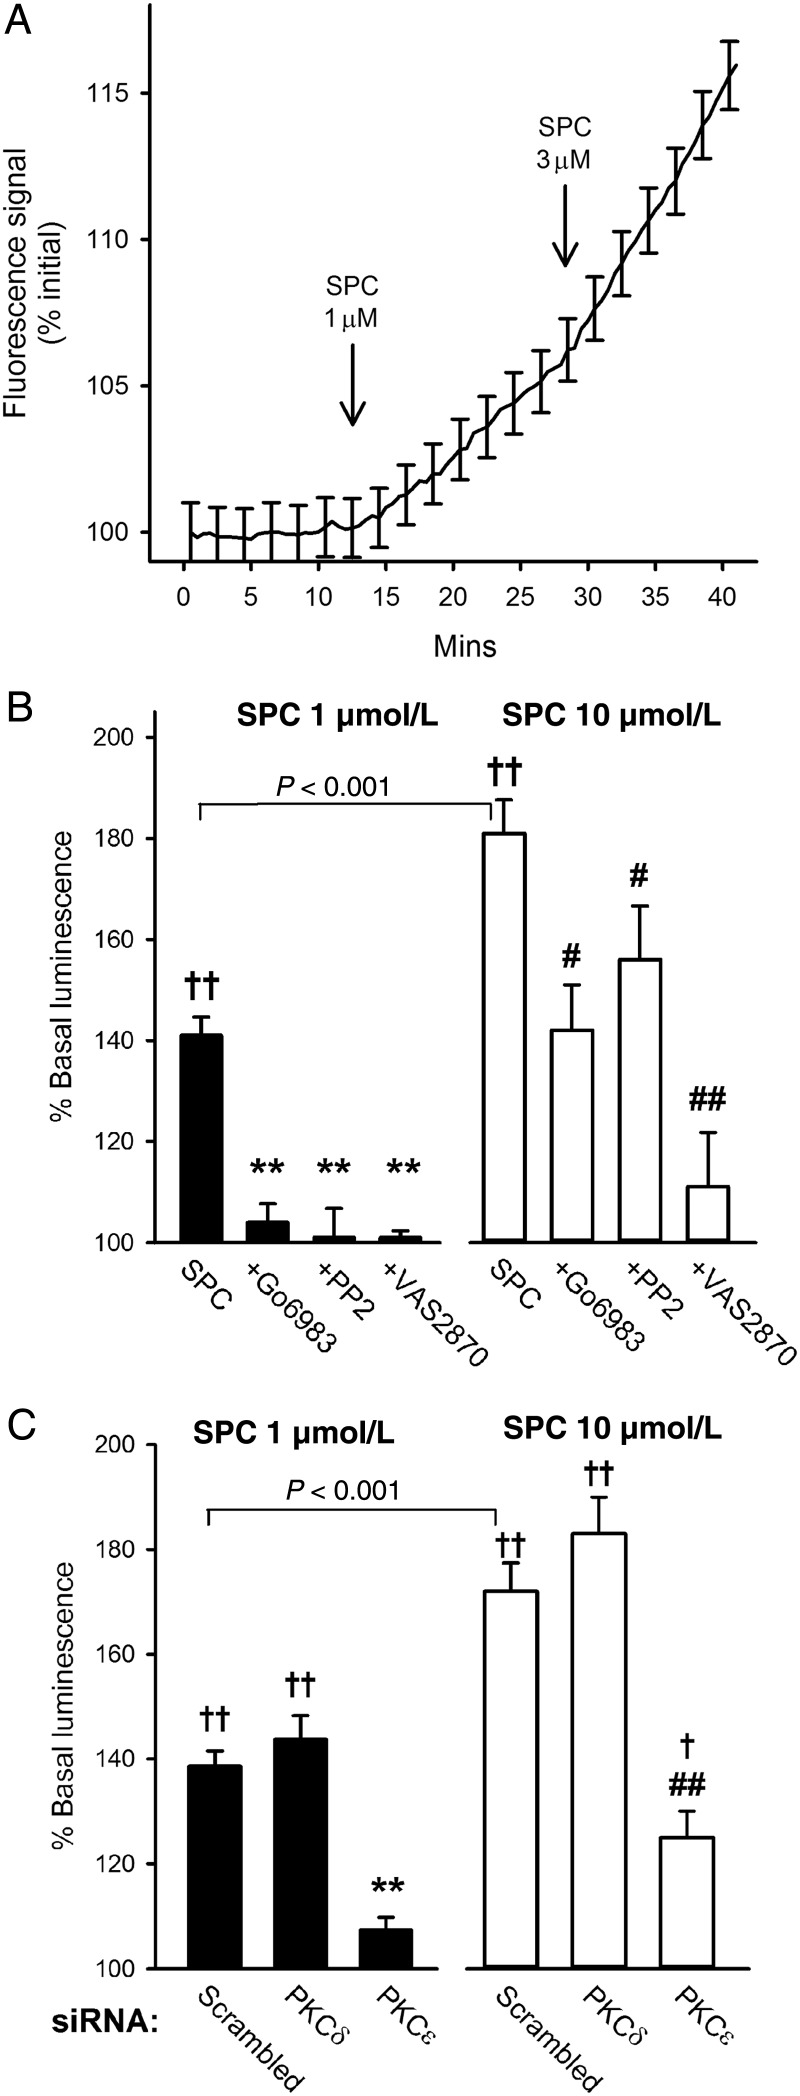
Effect of SPC on ROS generation. (A) Mean of real-time recordings from intact MA from three rats showing increased oxidation of C-DCFH (fluorescence at 530 nm) following addition of SPC. Data normalized to initial fluorescence; bars = SEM, shown at 2 min intervals for clarity. (B) Increase in lucigenin luminescence in PASMCs cultured from eight rats following addition of 1 (n = 11) or 10 (n = 12) µmol/L SPC, and in the presence of Gö6983 (n = 6 and 7), PP2 (n = 9 and 11), and VAS2870 (n = 4 and 4). †P < 0.01, ††P < 0.001 vs. control (no SPC); **P < 0.001 vs. 1 µmol/L SPC alone; #P < 0.05, ##P < 0.001 vs. 10 µmol/L SPC alone; one-way ANOVA, Holm-Sidak post hoc. Bars = SEM. (C) Increase in lucigenin luminescence following addition of 1 or 10 µmol/L SPC in PASMCs (cultured from six rats) transfected with scrambled siRNA (n = 12), PKCδ siRNA (n = 4), or PKCε-siRNA (n = 5). †P < 0.01, ††P < 0.001 vs. control (no SPC); **,##P < 0.001 vs. scrambled siRNA with 1 or 10 µmol/L SPC; one-way ANOVA, Holm-Sidak post hoc. Bars = SEM.